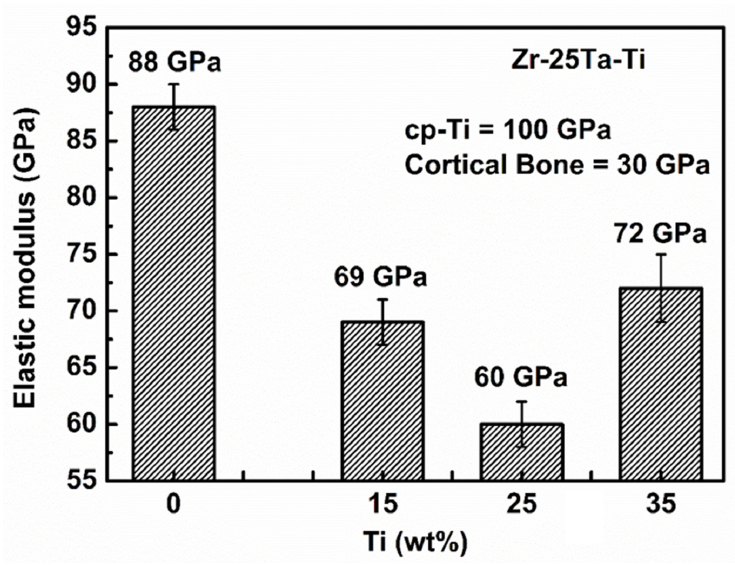
Figure 6. Elastic modulus as a titanium concentration function for all Zr-25Ta-xTi alloys used in this study.